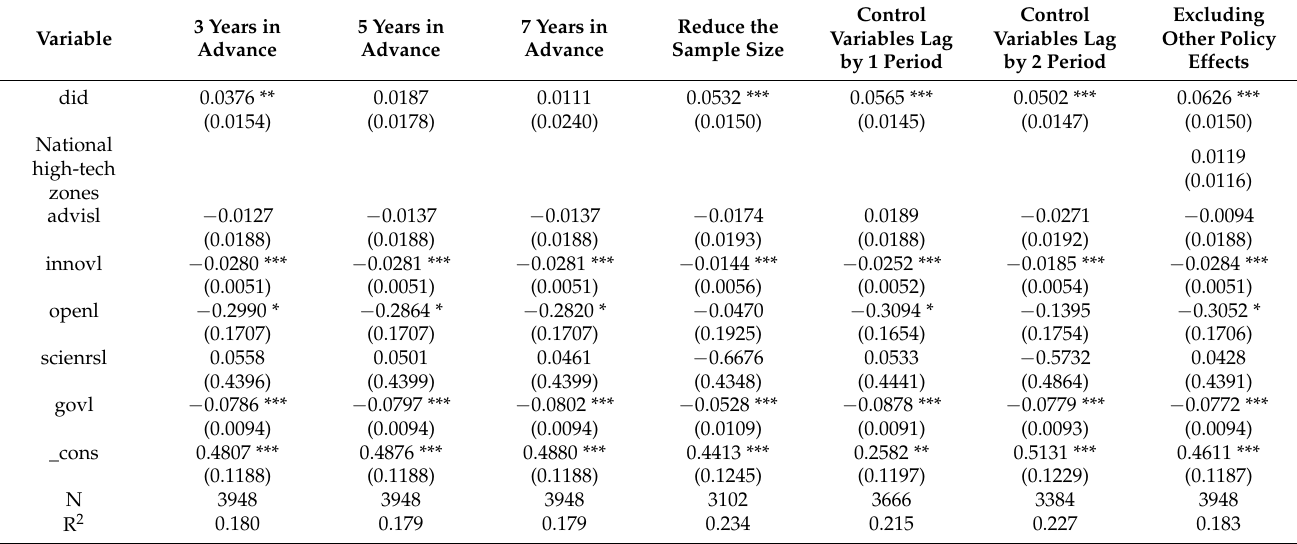
Table 6. The impact of national new areas on eco-efficiency: Other